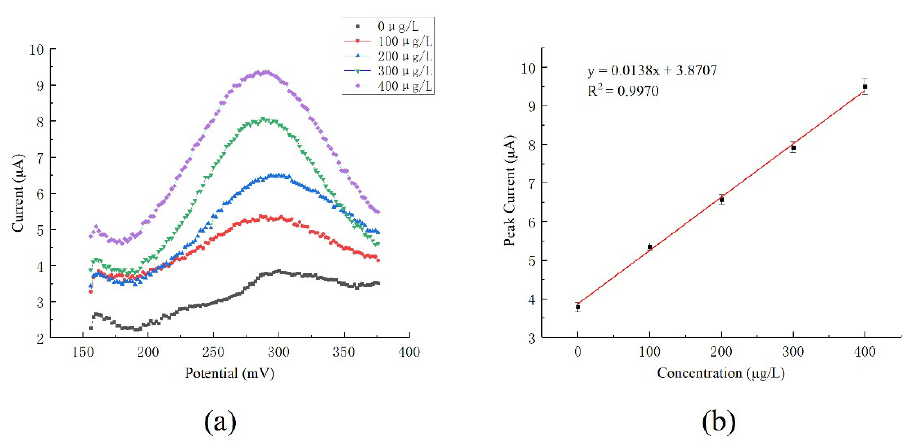
Figure 8. Cu 2+ concentration detection by the ultramicro electrode: ( a ) Cu 2+ concentration response curve; ( b ) Cu 2+ cur- rent–concentration fitting line. (The detection results are the average of three times.).